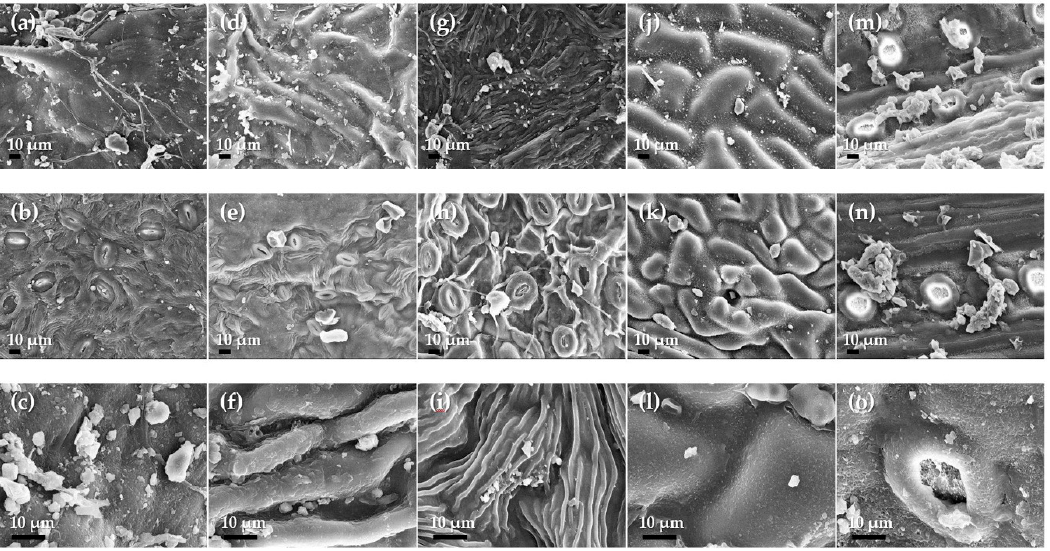
Figure 5. Variability of surface topography of adaxial leaf surfaces showing grooves and